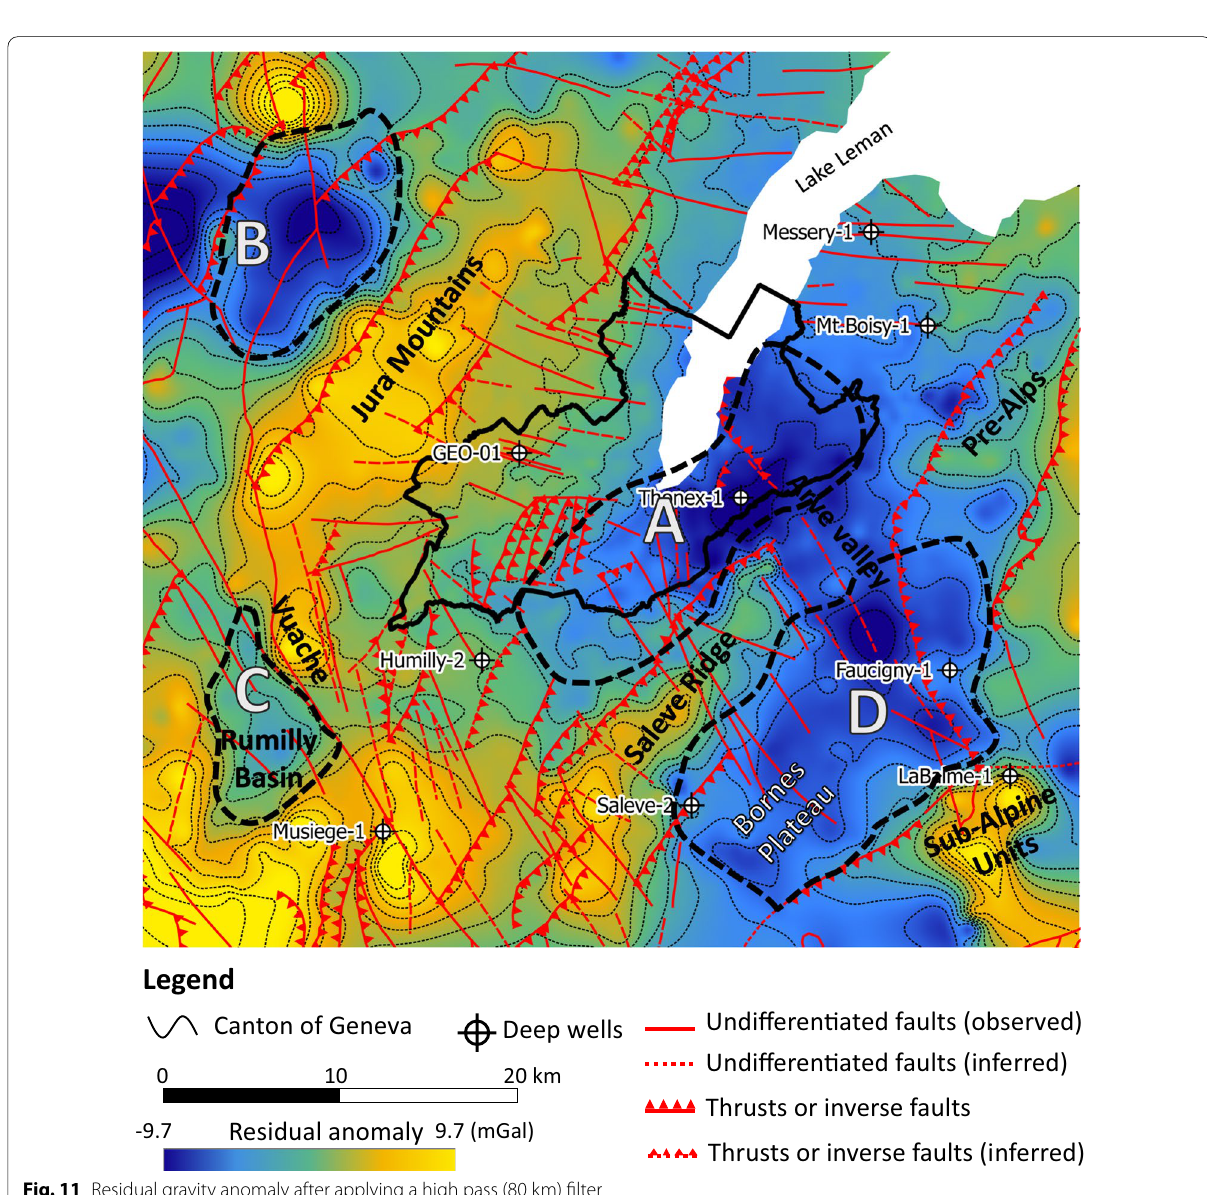
Fig. 11 Residual gravity anomaly after applying a high pass (80 km)